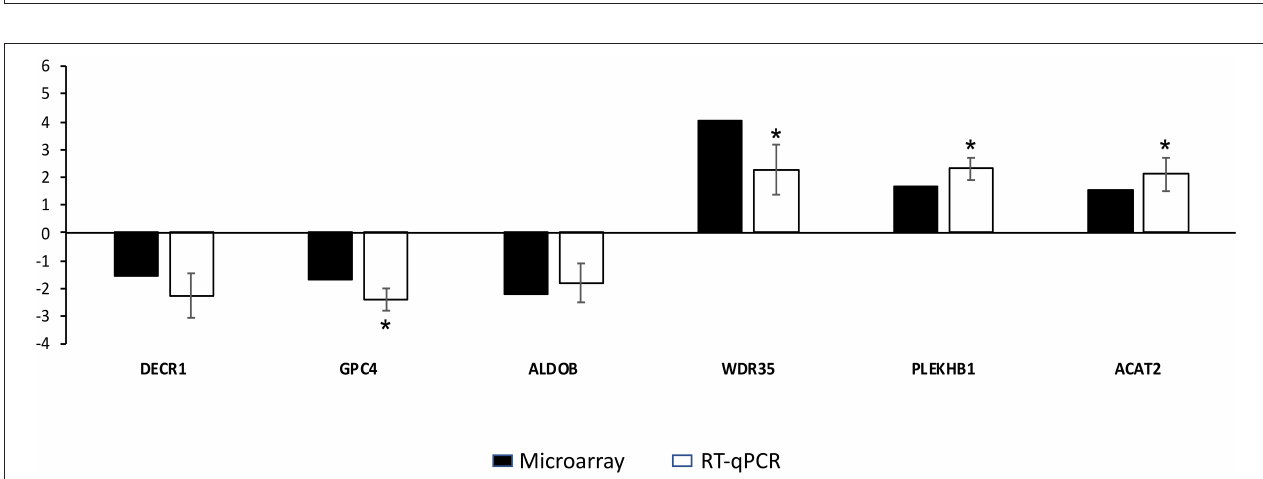
FIGURE 4 | Network representation of enriched pathways obtained from the differentially expressed genes in vitrified morulae. ClueGo v2.0.3 (Cytoscape v3.0.0 software) shows the interaction of functionally grouped gene clusters. Nodes in the same cluster have the same color and the size of the node represents the significance of the enrichment. Groups are labeled attending of common processes within the cluster. Edges indicate interactions between functional groups.